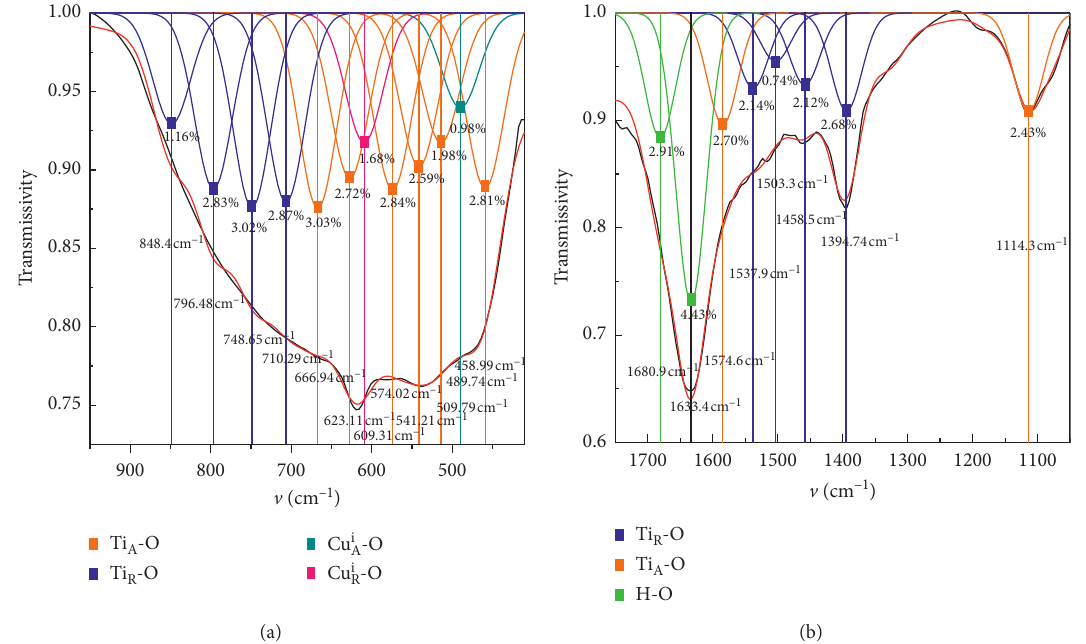
Figure 6: Infrared spectra of the 2.5mol%Cu-doped TiO 1000cm − 1 ∼ 1800cm − 1 . Table 5: Infrared spectra of the 2.5mol%Cu-doped TiO The type of